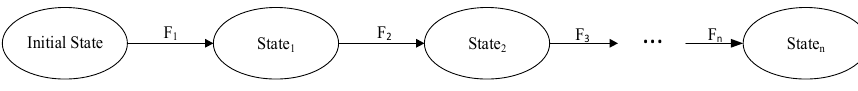
Figure 7. State transition diagram.